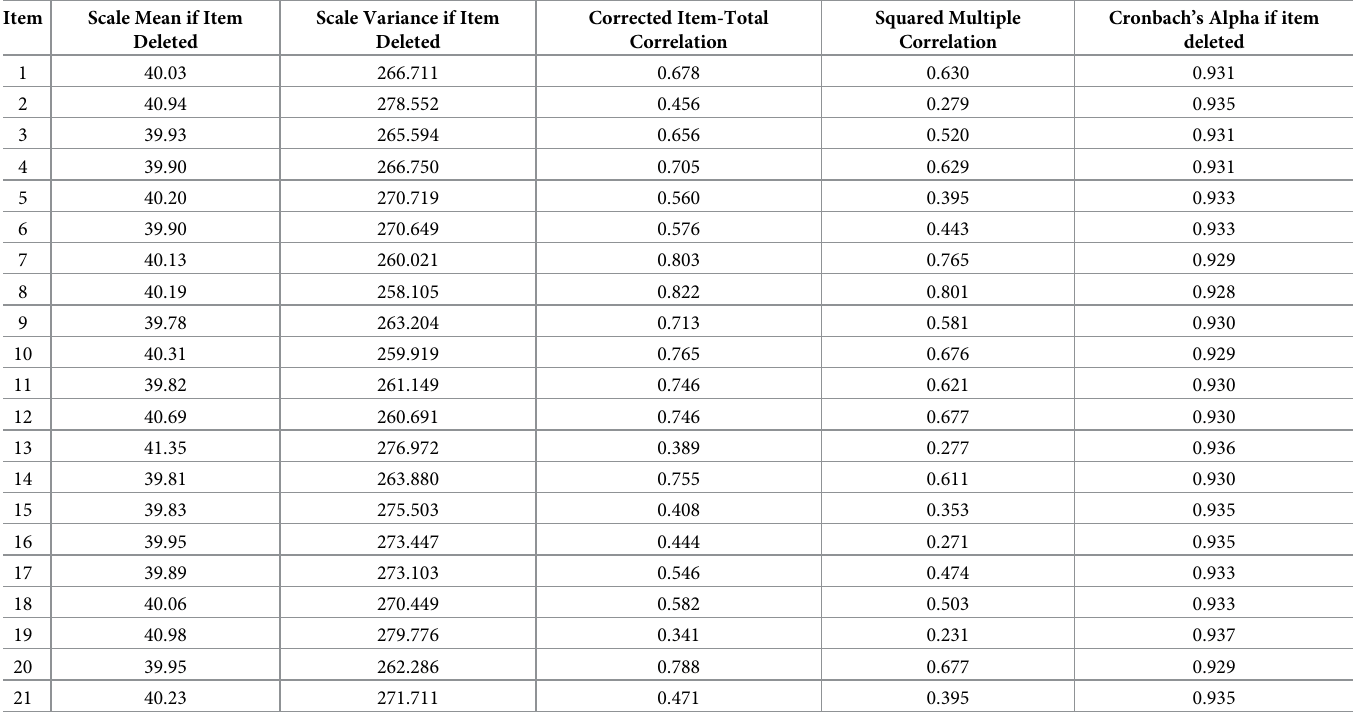
Table 3. Cronbach’s alpha for individual items of the RosQol (n = 265).